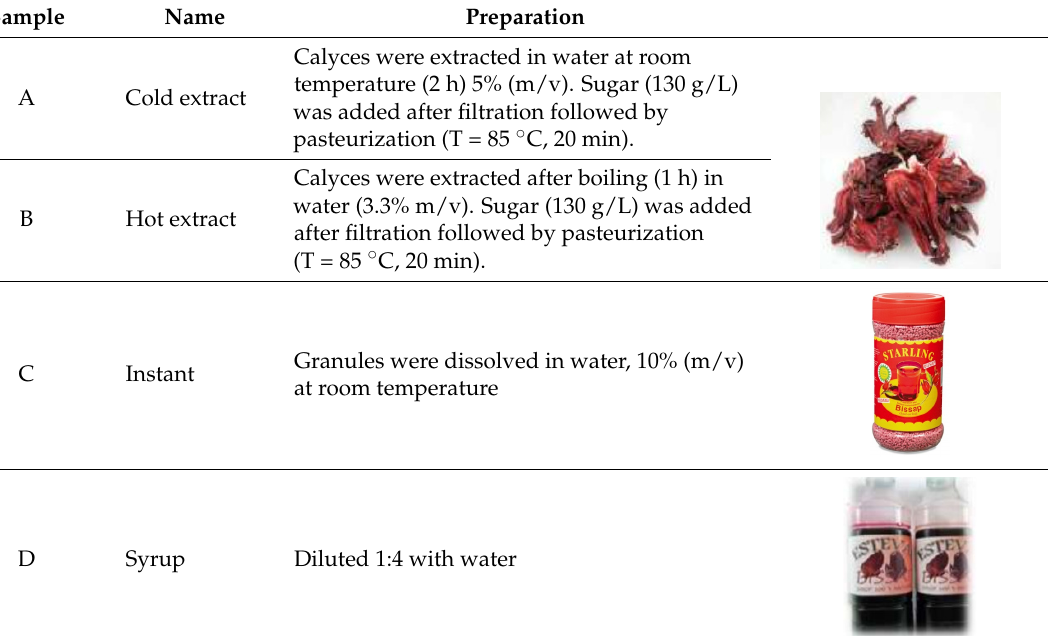
Table 3. Identification and preparation of the Bissap samples.